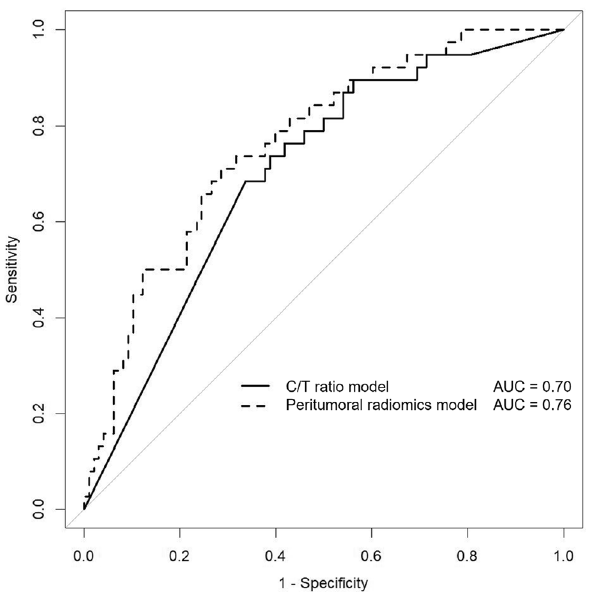
Figure 4. ROC curve of the C/T ratio model and the peritumoral radiomics model.